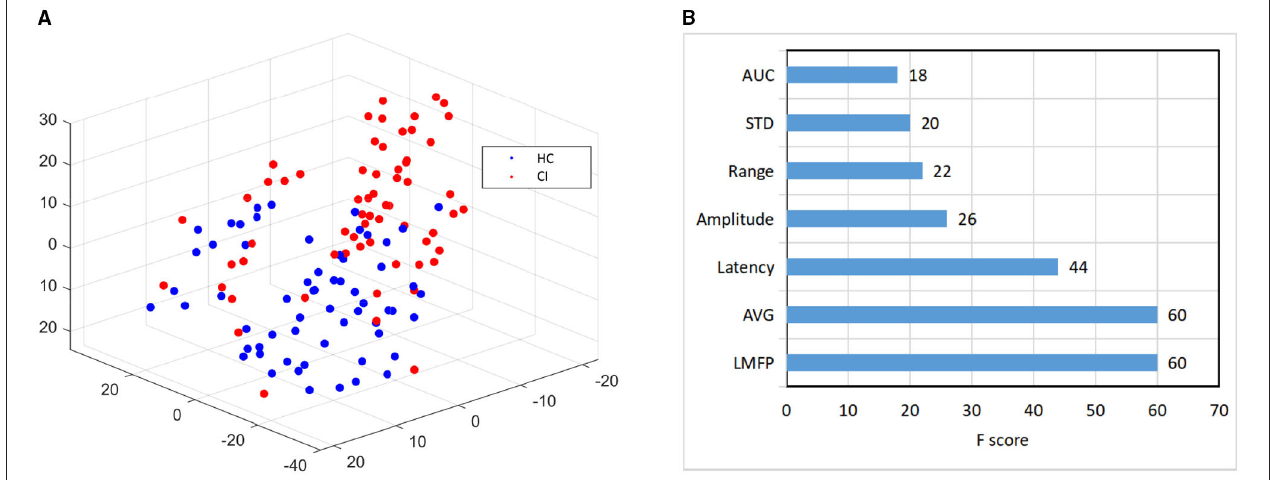
FIGURE 5 | Feature visualization and importance comparison. (A) The visualization features map based on t-Distributed Stochastic Neighbor Embedding (t-SNE) dimension-reduction. (B) The feature importance based on